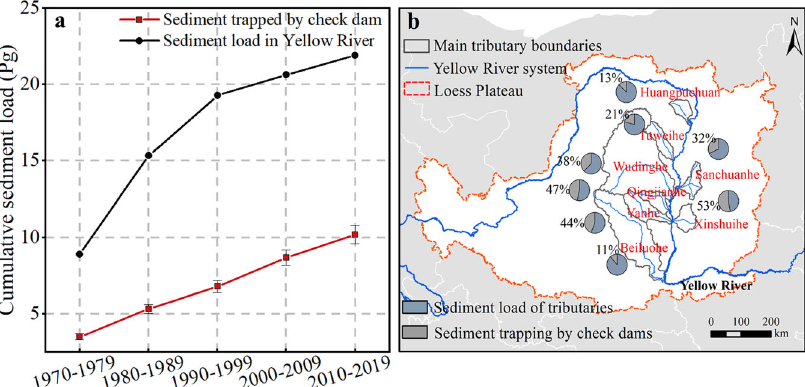
Fig. 3 Check dams trapped sediment. a Sediment trapped by check dams and sediment load of the Yellow River at different historical stages. Error bars represent standard deviation. b Sediment retention bene fi ts of check dams in 8 main tributaries of the Yellow River. The river sediment load data is provided by the national basic hydrological station at the outlet of each basin, without error